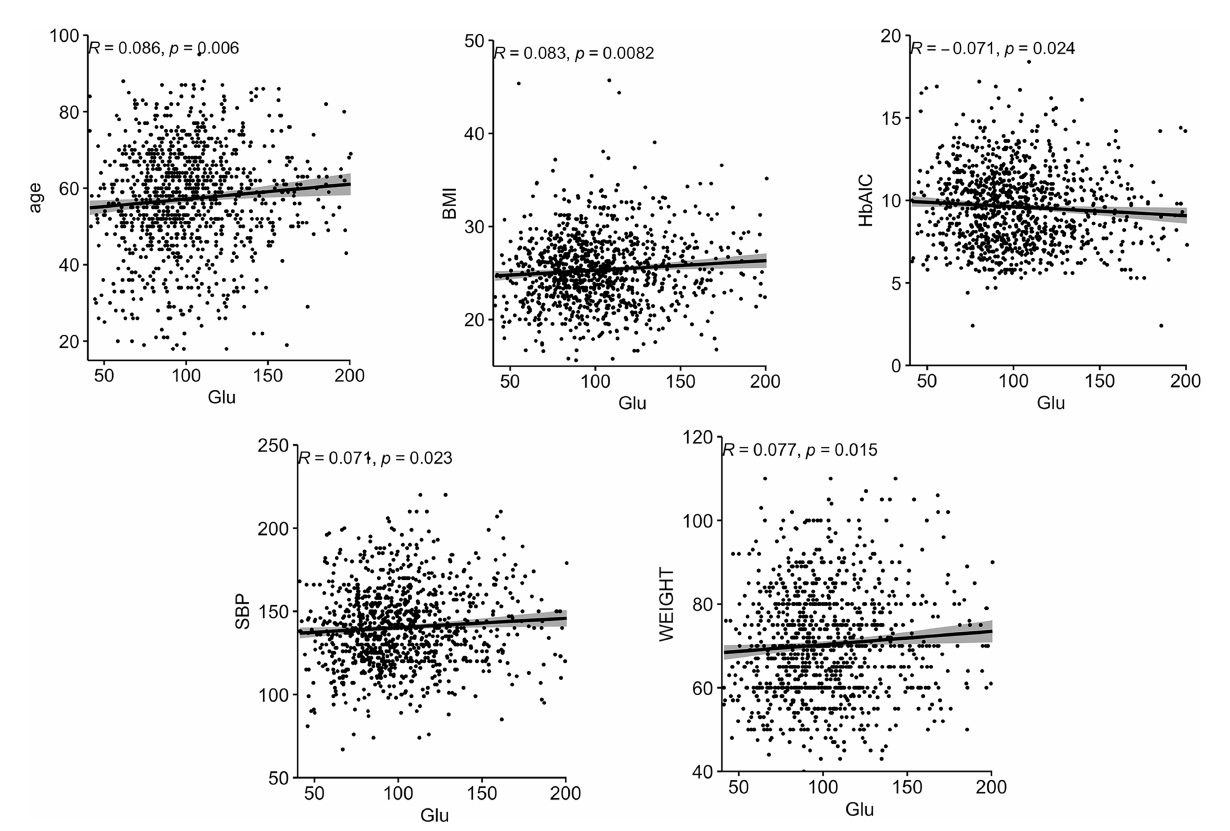
FIGURE 2 Correlation between Glu and various biochemical indicators in the female group. BMI, body mass index; SBP, systolic blood pressure; Glu,